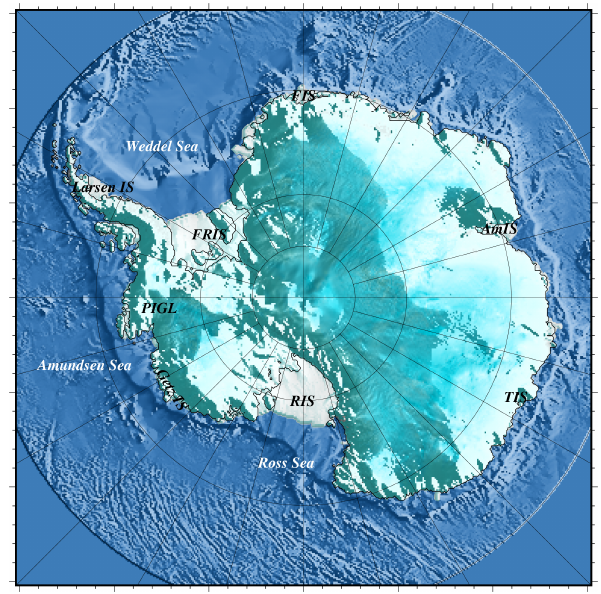
Figure 1. The Antarctic ice sheet with the major ice shelves dis- cussed in the text: Larsen Ice Shelf, Filchner–Ronne Ice Shelf (FRIS), Pine Island Glacier Ice Shelf (PIGL), Getz Ice Shelf, Ross Ice Shelf (RIS), Totten Ice Shelf (TIS), Amery Ice Shelf (AmIS) and Fimbul Ice Shelf